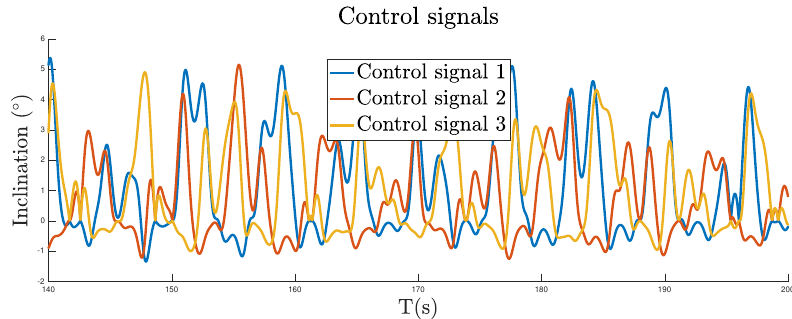
Figure 8. Control signal for the validation test.